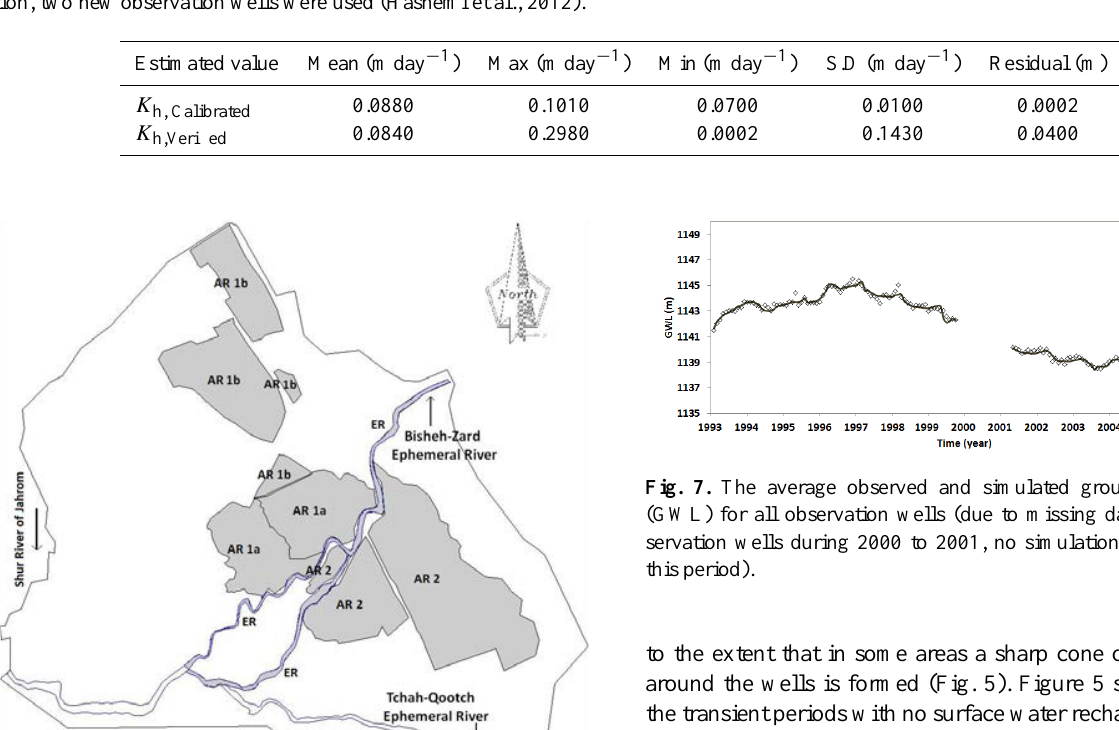
Table 2. Calibration results for ten steady-state modeled periods between 1993 and 2007 and verification result for 2008. In model verifica- tion, two new observation wells were used (Hashemi et al., 2012).